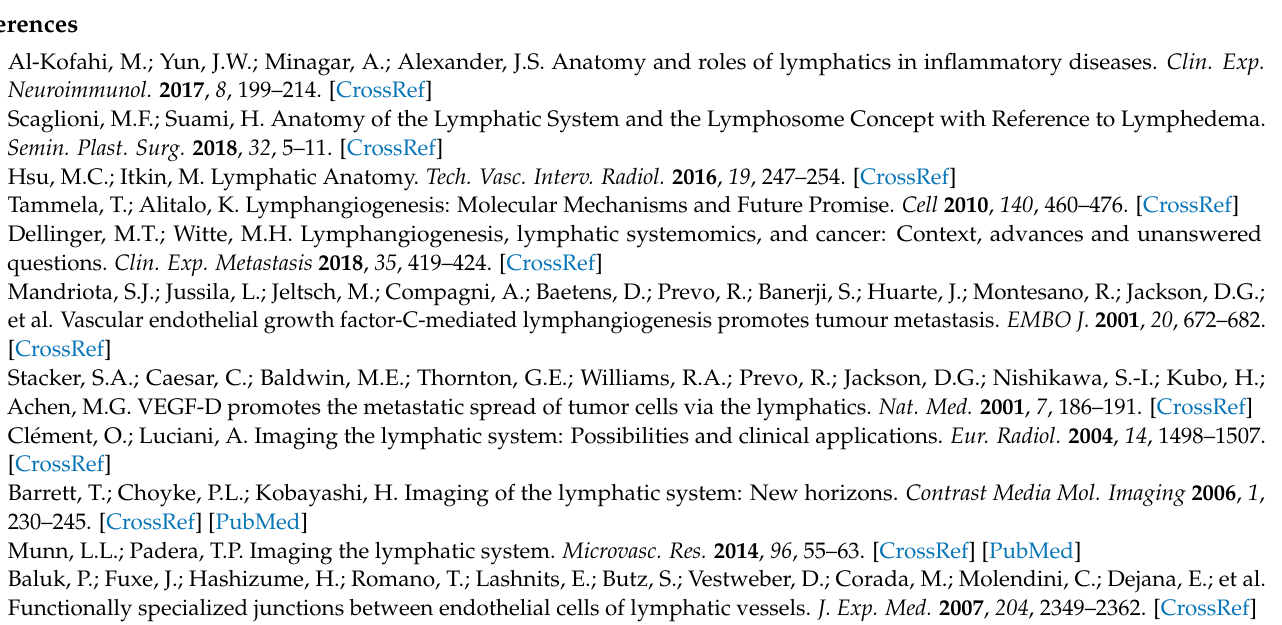
Figure 18. A 76-year-old male patient with a history of tongue base cancer status post-chemoradiation and left upper extremity lympho-venous bypass due to swelling of his left arm. Lymphoscintigraphy was performed by injection of sulfur colloid (radiotracer) into both hands. ( A ) The patient position. ( B ) Right anterior scintigraphy position with accumulation of tracer in both hands and tracer uptake in the right arm (black arrow). ( C , D ) Fused SPECT/CT with transit of tracer via proximal arm LN (white arrow in ( C )) to reach lymph nodes at right axilla (white arrow ( D )) with absence of any tracer uptake in the whole left upper extremity, confirming normal lymphatic drainage of the right arm with lymphedema of the left